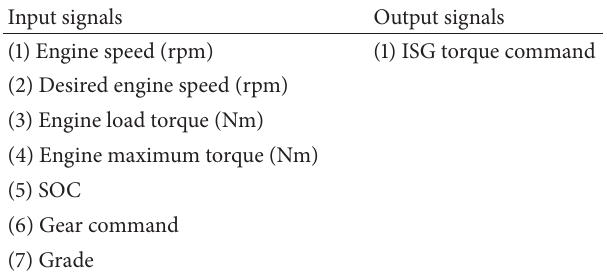
Table 3: Rule-based logic